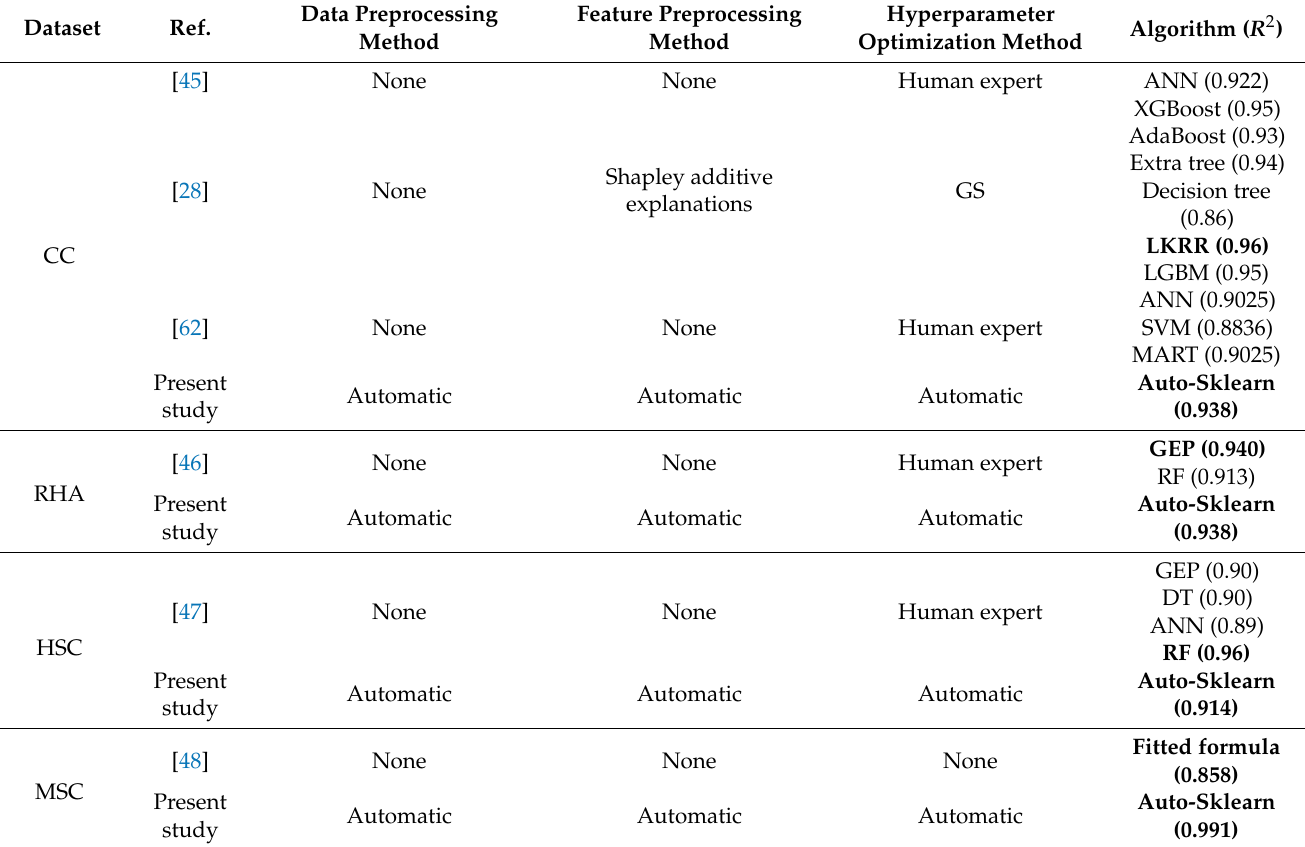
Table 9. Performance evaluation index values from related